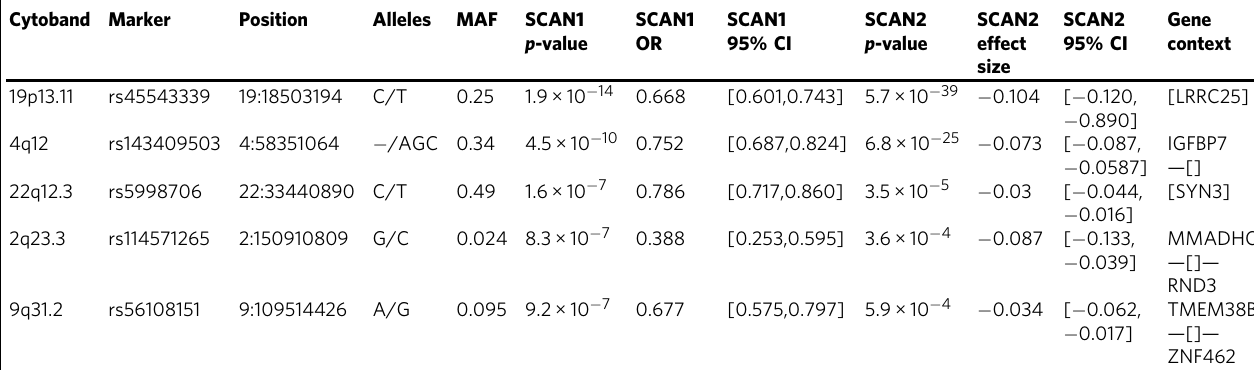
Table 2 Results of the genome-wide association study of no NVP vs HG (SCAN1) with p < 10 − 6 . The directions of odds ratios (OR) correspond to the minor allele, listed second Cytoband